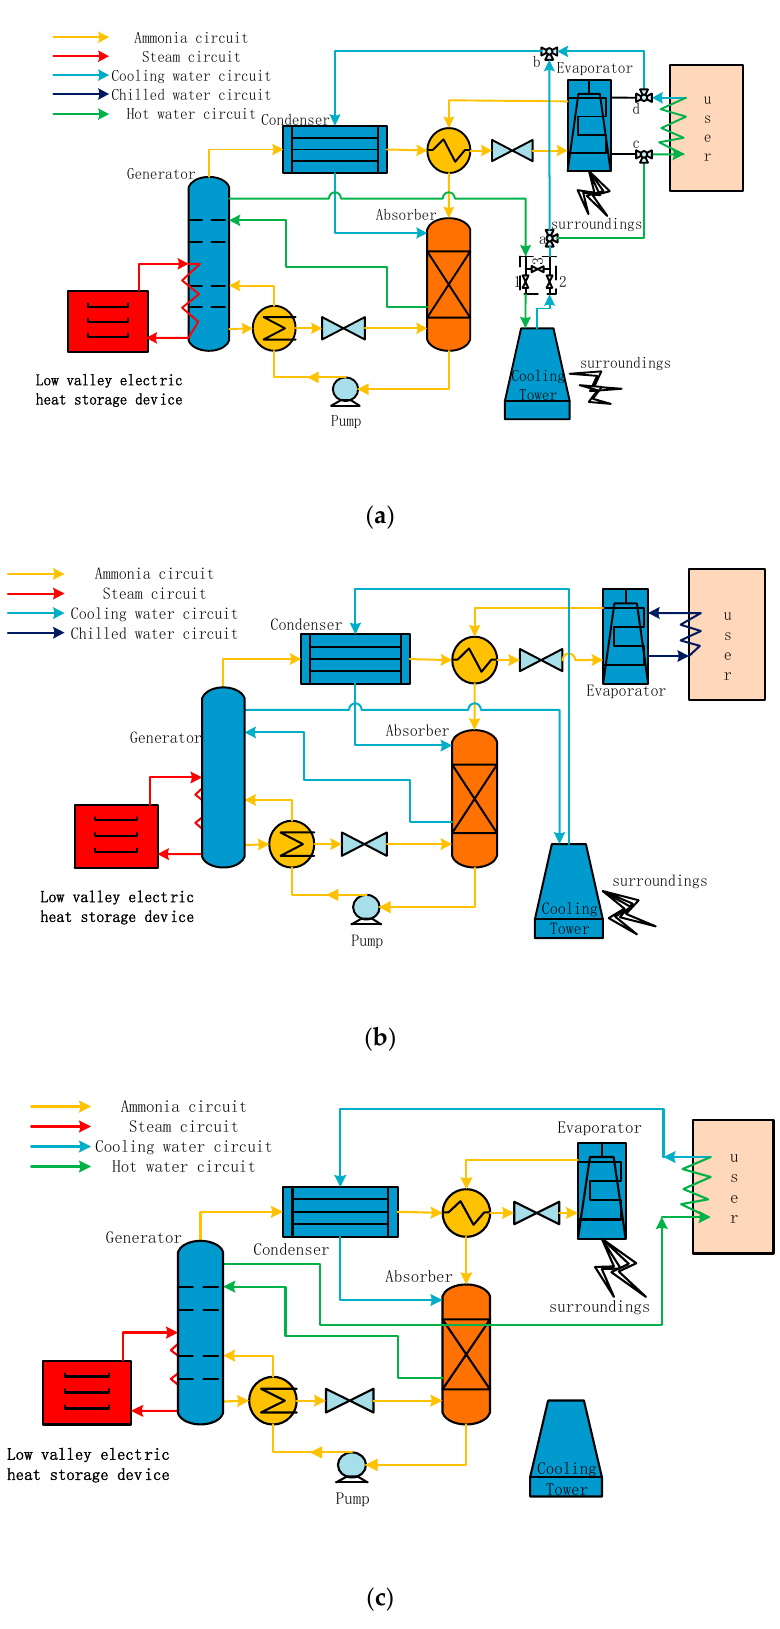
Figure 1. ( a ) Schematic of ammonia absorption cooling and heating dual-supply system (AACHDSS) based on off-peak electricity heat storage. ( b ) Schematic of AACHDSS based on off-peak electricity heat storage in summer. ( c ) Schematic of AACHDSS based on off-peak electricity heat storage in winter.